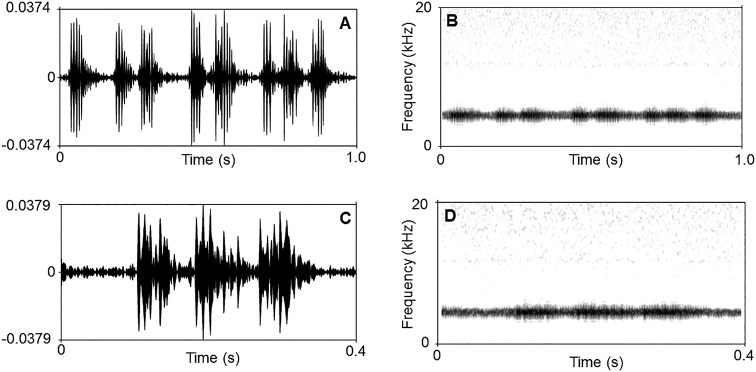
Advertisement calls of the holotype CIBCS20190518047 of Leptobrachella
chishuiensis sp. nov. A waveform showing one second contains 4 calls B sonogram showing one second contains 4 calls C waveform showing 0.4 second contains a call D sonogram showing 0.4 second contains a call.